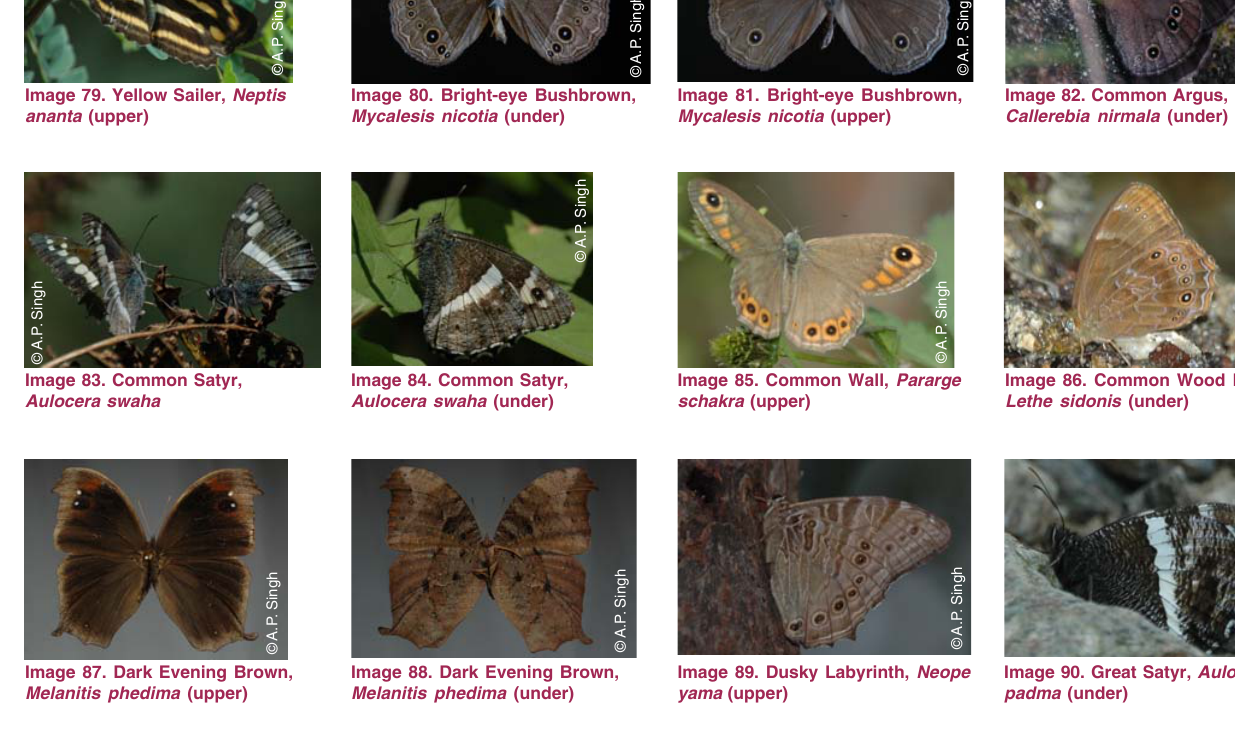
Image 88. Dark Evening Brown, Melanitis phedima (under)